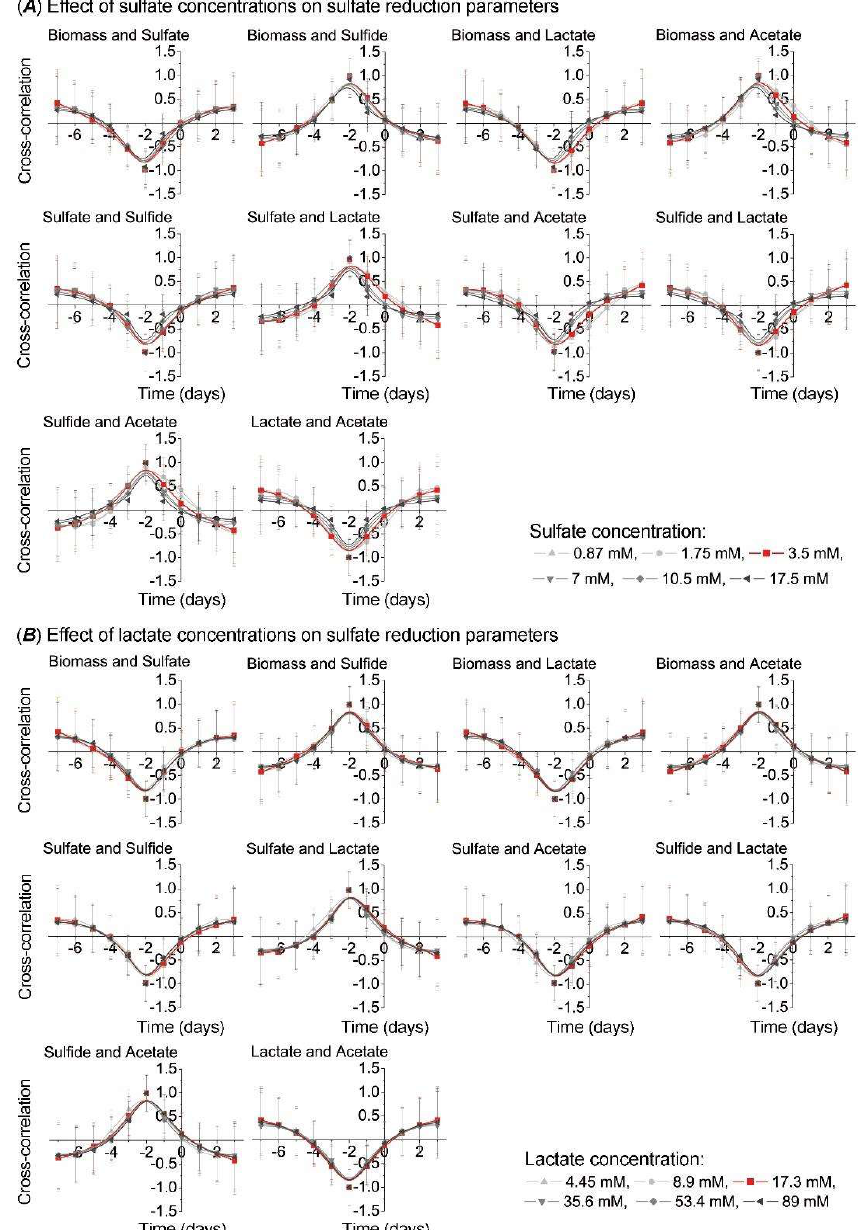
Figure 4. Cross-correlation analysis between growth (biomass) and sulfate reduction parameters under the effect of electron acceptor (sulfate)/donor (lactate) at different concentrations.